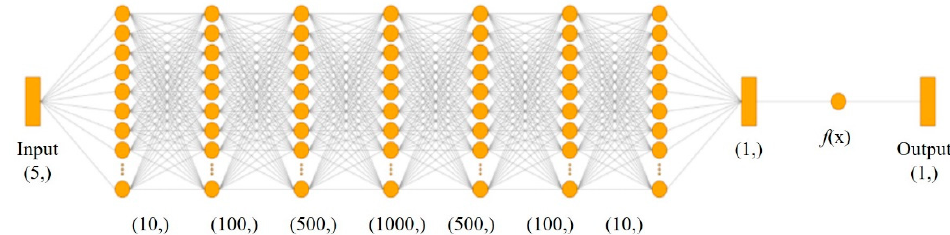
Figure A3. A graphical representation of the deep neural network structure. The numbers in the parentheses represent units in each layer and f (x) is the activation function.